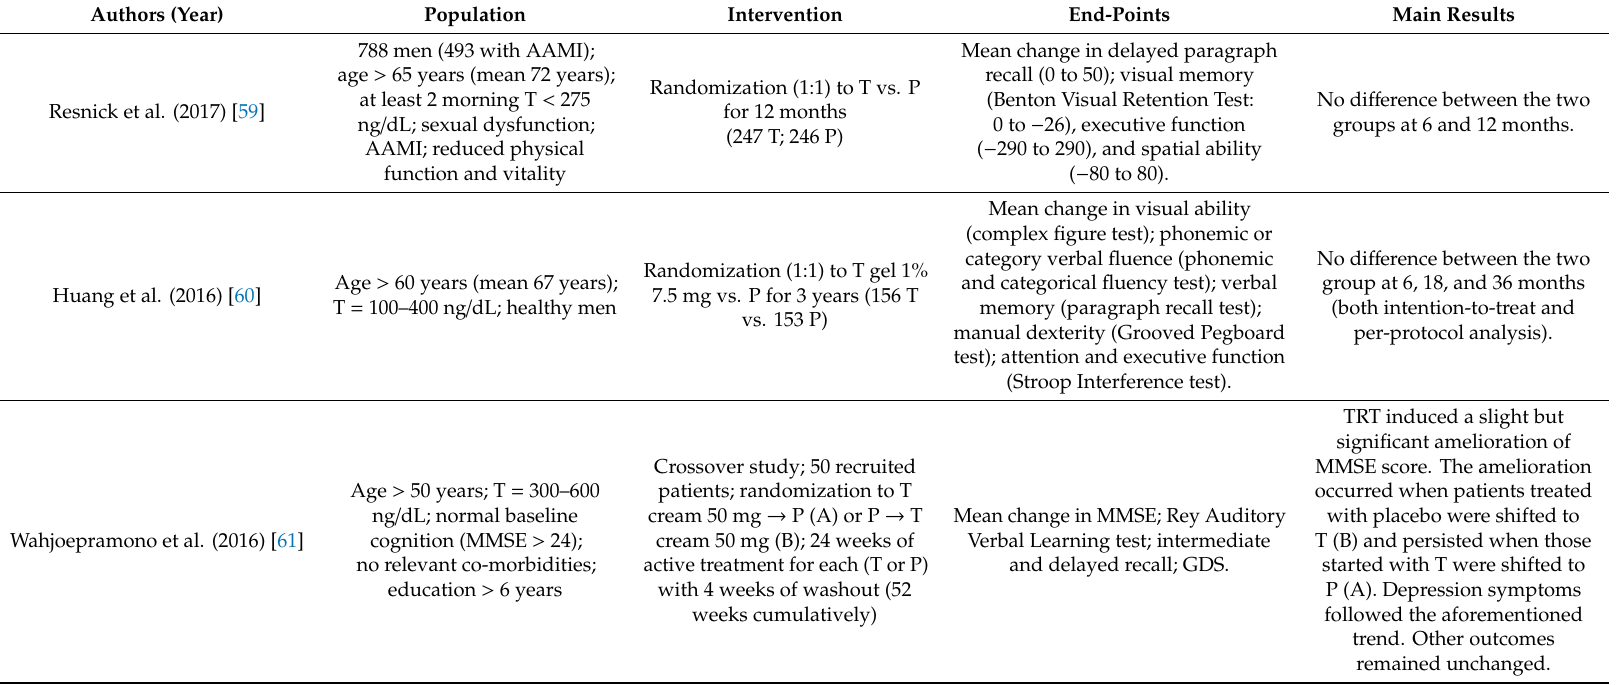
Table 1. Summary of randomized controlled trials that investigated the e ff ect of testosterone supplementation in hypogonadal and eugonadal men with and without baseline cognitive